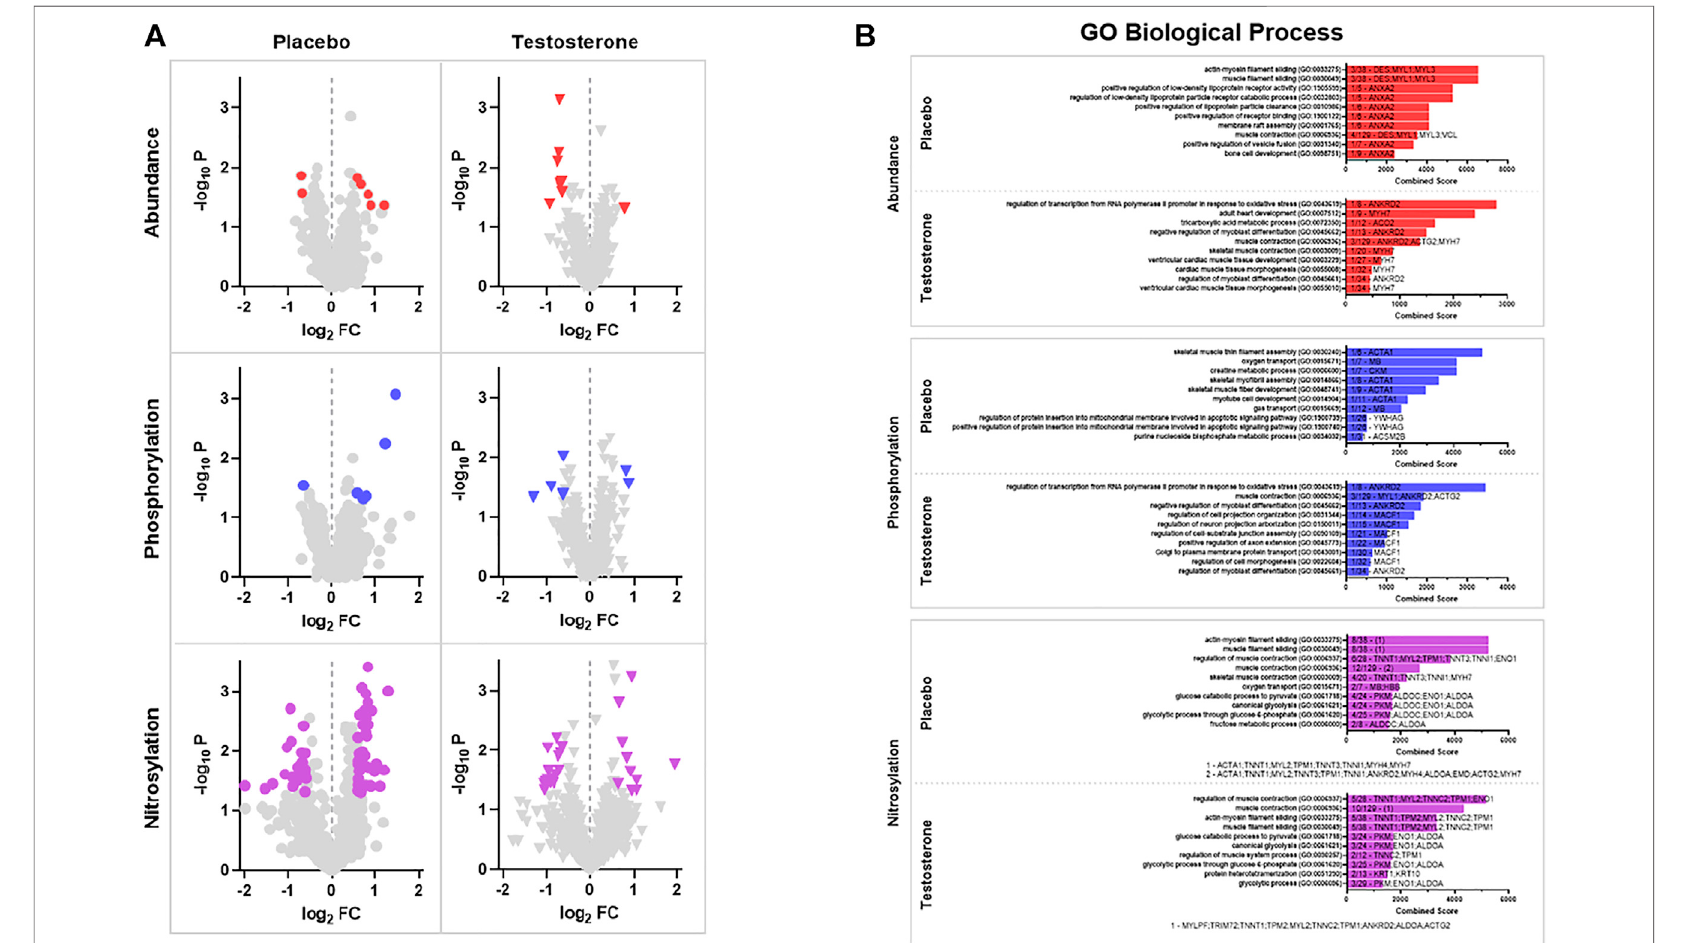
FIGURE 2| Geneset enrichment analysis(GSEA). (A) VolcanoPlots. Volcanoplots ofprotein spots identi fi ed by2Delectrophoresis represented as-log10 p -value vs. log2offoldchange frompre topost. Proteins were deemed signi fi cantly altered with a p < 0.05 and a log2 fold change > 1.5 (increased) or < − 1.5 (decreased). Analyses identi fi ed signi fi cant differences in abundance (red), phosphorylation (blue), and S-nitrosylation (purple)betweenpreandposttreatmentbiopsiesforasubsetofproteins(signi fi cantlyalteredproteinsarecolored). (B) GeneOntology(GO).Signi fi cantlyalteredproteinswereusedtoidentifyaffectedgenesetsusingthe 2021 GO Biological Process 2021 database. The top 10 pathways identi fi ed by Enrichr combined score (see text for description) are displayed. Pathways that were identi fi ed as signi fi cantly altered (adjusted p < 0.05) are denoted by a dark colored bar for abundance (red), phosphorylation (blue), and S-nitrosylation (purple). The number and identity of signi fi cantly altered proteins and total number of proteins in the identi fi ed pathway are denoted on each bar. (C) Kyoto Encyclopedia of Genes and Genomes (KEGG). Signi fi cantly altered proteins were used to identify affected pathways using the 2021 KEGG pathway database. The top 10 pathways identi fi ed by Enrichr combined score (see text for description) are displayed. Pathways that were identi fi ed as signi fi cantly altered (adjusted p < 0.05) are denoted by a dark colored bar for abundance (red), phosphorylation (blue), and S-nitrosylation (purple). The number and identity of signi fi cantly altered proteins and total number of proteins in the identi fi ed pathway are denoted on each